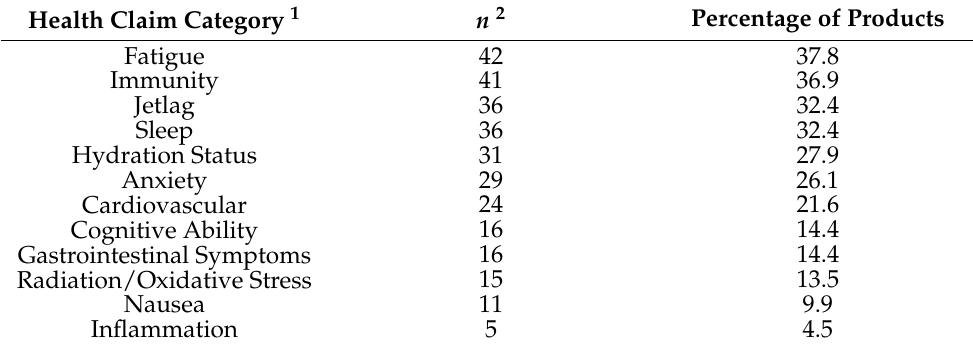
Table 1. Health claims made by products ( n = 111) identified in scoping review of functional foods, beverages and nutritional supplements that target air travel symptoms.